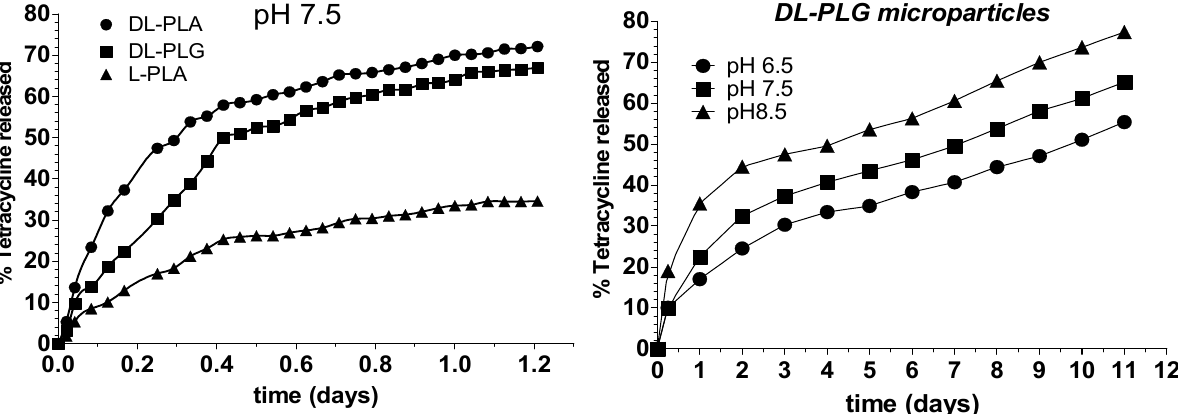
Figure 3. Tetracycline release profiles obtained from microparticles elaborated with DL and L- PLA and DL-PLG using a release buffer of pH 7.5 (right) and from DL-PLG microparticles in tree buffers with different pH. Modified with permission from Informa Healthcare